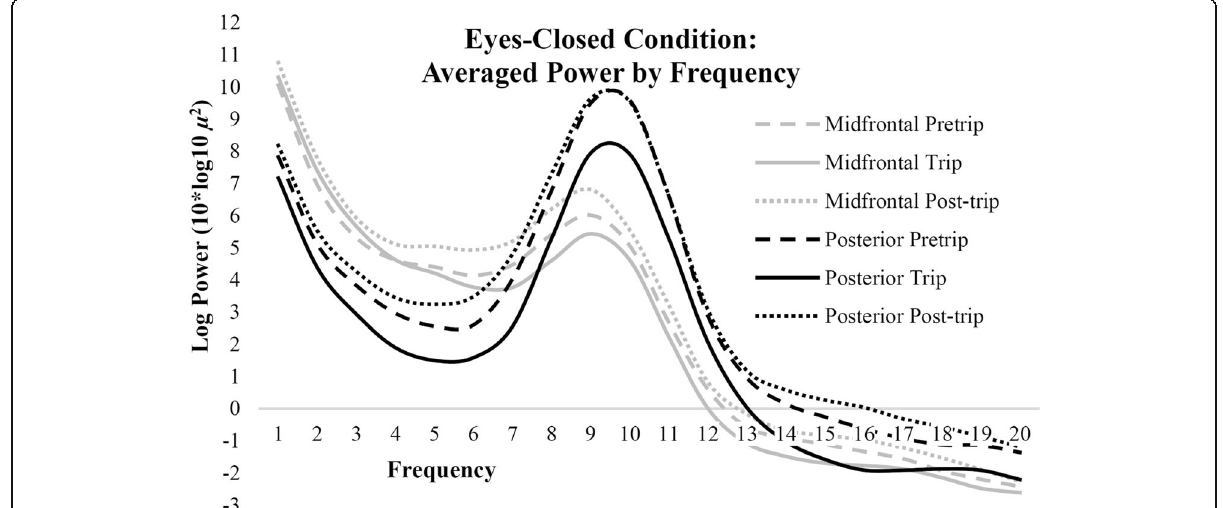
Fig. 5 Spectra for each session averaged across midline and posterior electrodes during the eyes-closed